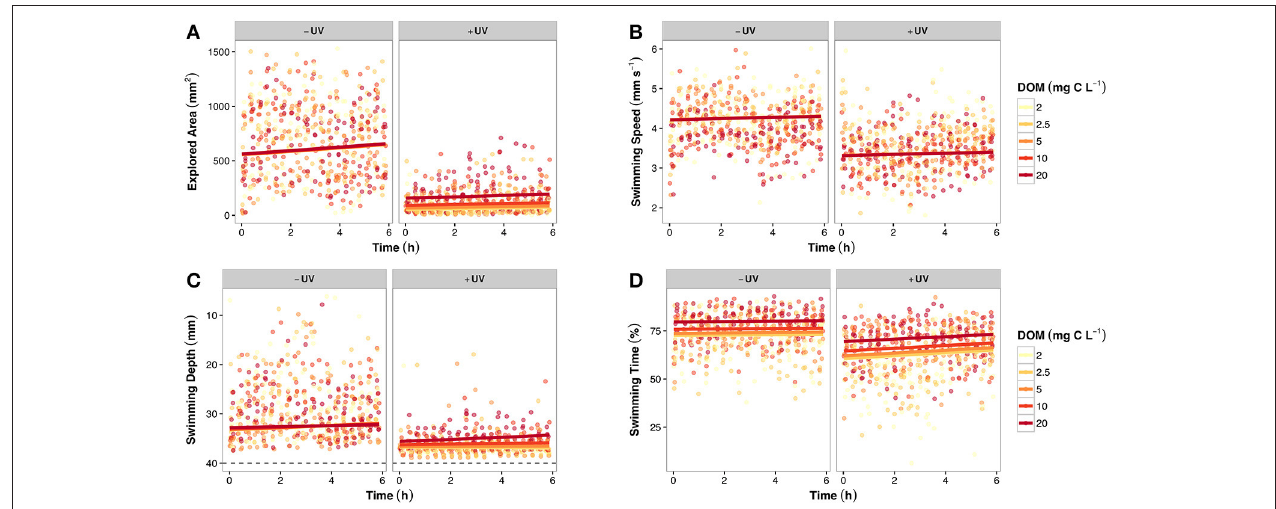
FIGURE 2 | Overview of four different swimming behavior proxies over time, separated by UVR presence and differentiated by DOM concentrations (color gradient). Points are raw data and solid lines are the predictions of the best-fit LME models (see the Materials and Methods section for details). (A) Development of explored area (mm 2 ). Note the strong inhibiting effect of UVR, as well as the monotonous increase along the DOM gradient. (B) Overview of the swimming speed (mm s − 1 ) of daphnids. Note the overall negative influence of UVR and the lack of any DOM-related effects. (C) Overview of the swimming depth (mm). Note the severe flight behavior under UVR treatment, as well as the concentration-dependent DOM effect. The dashed black line indicates the bottom of the flask, i.e., the physical limitation to the swimming depth. (D) Overview of the development of the swimming time (%). Compared to the other swimming behavior proxies, the effect of UVR seems to be moderate, while there is a strong influence of